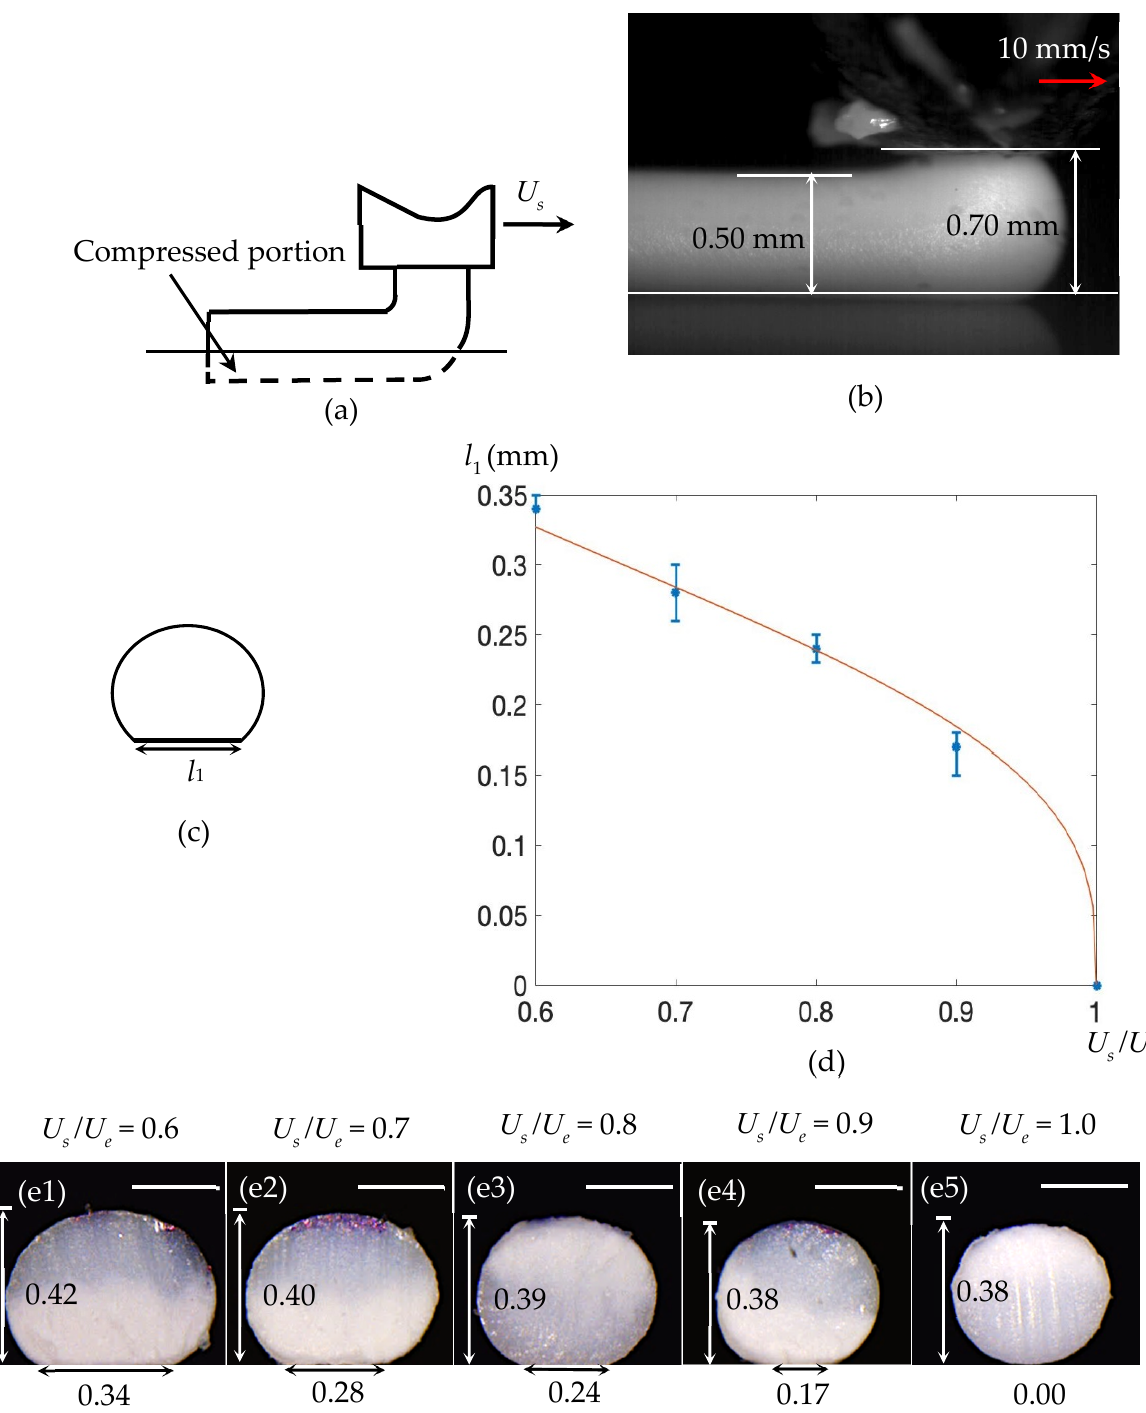
Figure 5. ( a ) Illustration of Case II.1. ( b ) A representative example, in which an ABS strand was extruded through a nozzle with diameter 0.40 mm when H = 0.70 mm, U e = 16.5 mm/s and U s = 10 mm/s. ( c ) Predicted cross-section of a deposited strand. ( d ) Theoretical and experimental results. The curve denotes the theoretical prediction obtained using Equation (48). ( e1 – e5 ) Cross-sections of the deposited strands, when H was fixed to be 0.50 mm and U s /U e ranged from 0.6 to 1.0. Scale bar: 0.25 mm.